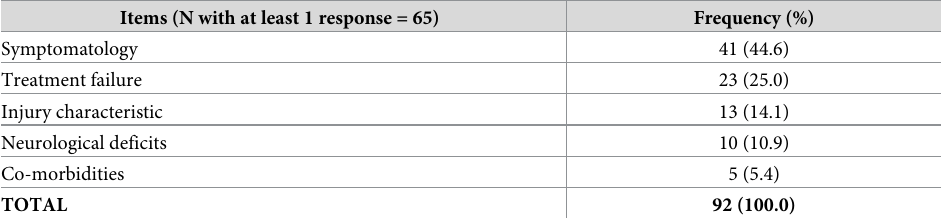
Table 4. Factors that determine when patient referred to a rehabilitation provider or higher level of care.